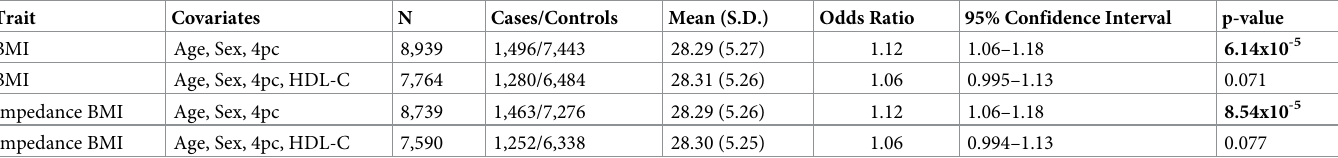
Table 2. Effect of body mass index.